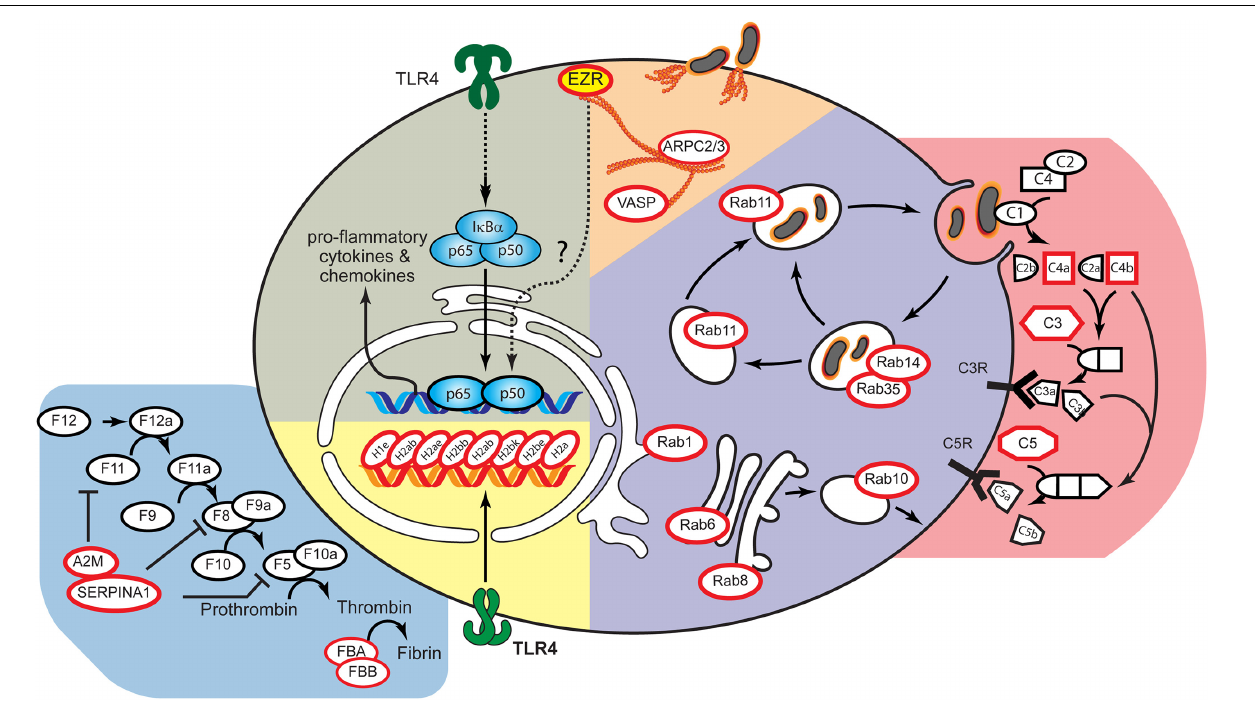
FIGURE 3 | Integrated model of host factors whose expressions were altered after B. mallei infection. Using the B. mallei infection lifecycle as a guide (Galyov et al., 2010), the candidate proteins were placed at the position most likely to be relevant to the B. mallei infection using a database of annotations from Gene Ontology and Kyoto Encyclopedia of Genes and Genomes (KEGG). Red circle represent proteins whose expressions were altered after B. mallei infection. The yellow solid circles were validated host factors whose functions are involved in pro-inflammatory responses upon B. mallei